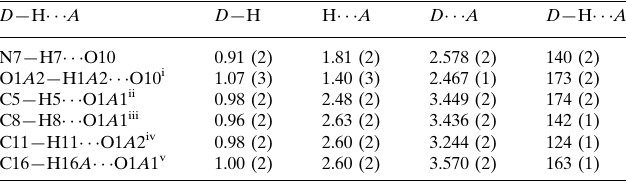
Hydrogen-bond geometry (A˚ , (cid:2)